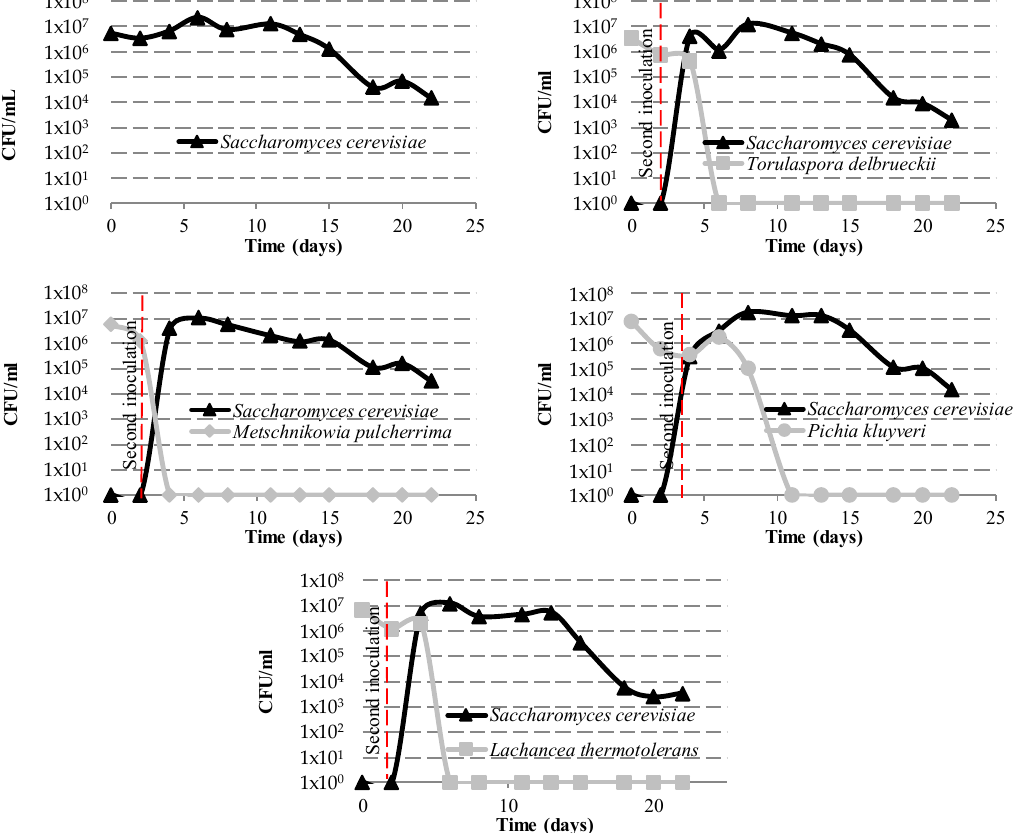
Figure 1. Population development of Saccharomyces cerevisiae , Torulaspora delbrueckii , Metschnikowia pulcherrima , Pichia kluyveri , and Lachancea thermotolerans during the fermentation process of the different trials.